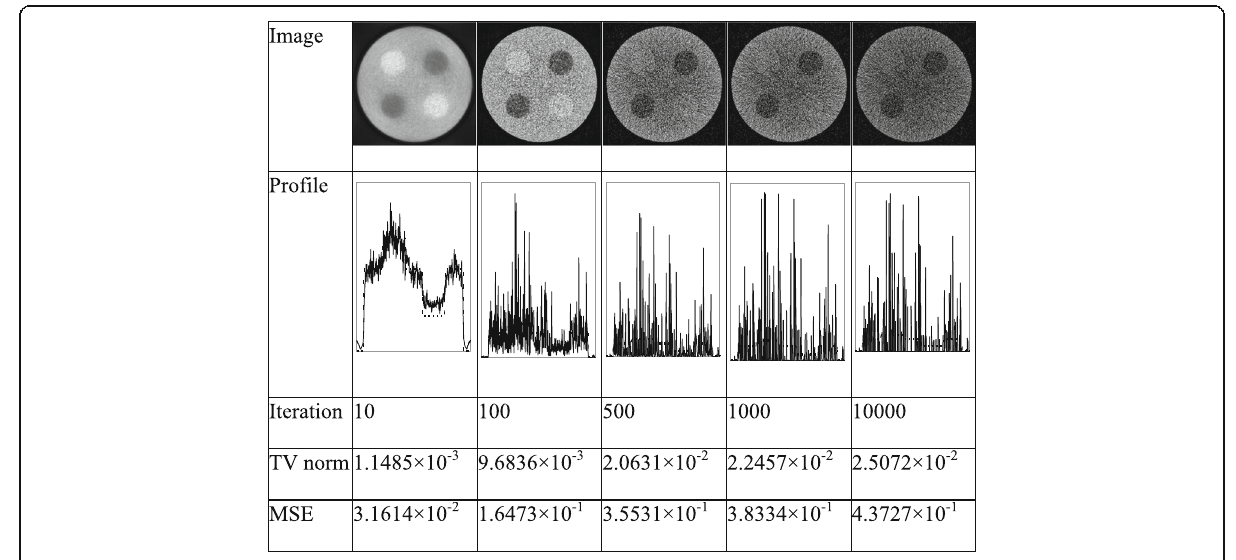
Fig. 7 Reconstructions of transmission data using algorithm (14) when I 0 = 100